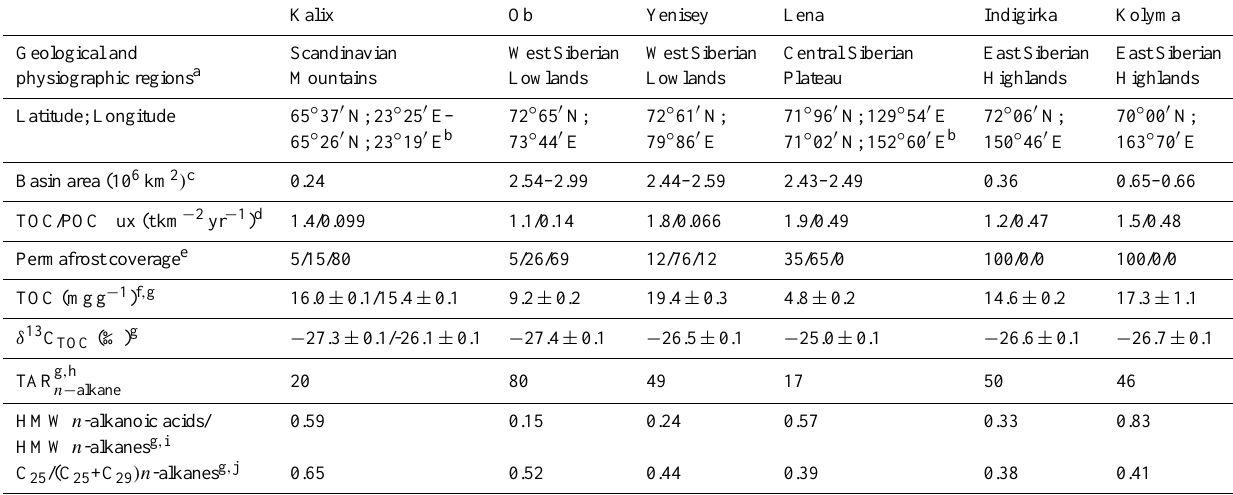
Table 1. Sample location, hydrological and bulk geochemical data of the surface sediments of Eurasian Arctic River Estuaries. Kalix Ob Yenisey Lena Indigirka Kolyma Geological and Scandinavian West Siberian West Siberian Central Siberian East Siberian East Siberian physiographic regions a Mountains Lowlands Lowlands Plateau Highlands Highlands Latitude;